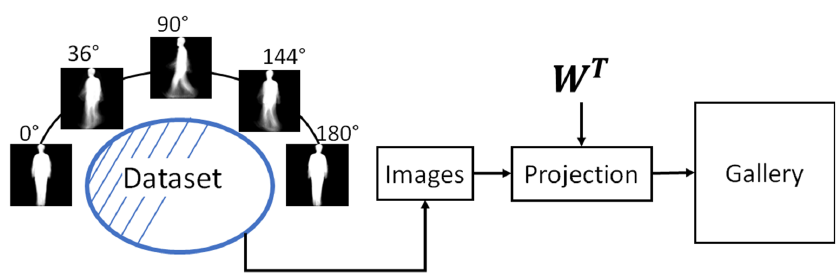
Figure 7. Block diagram of gallery construction.